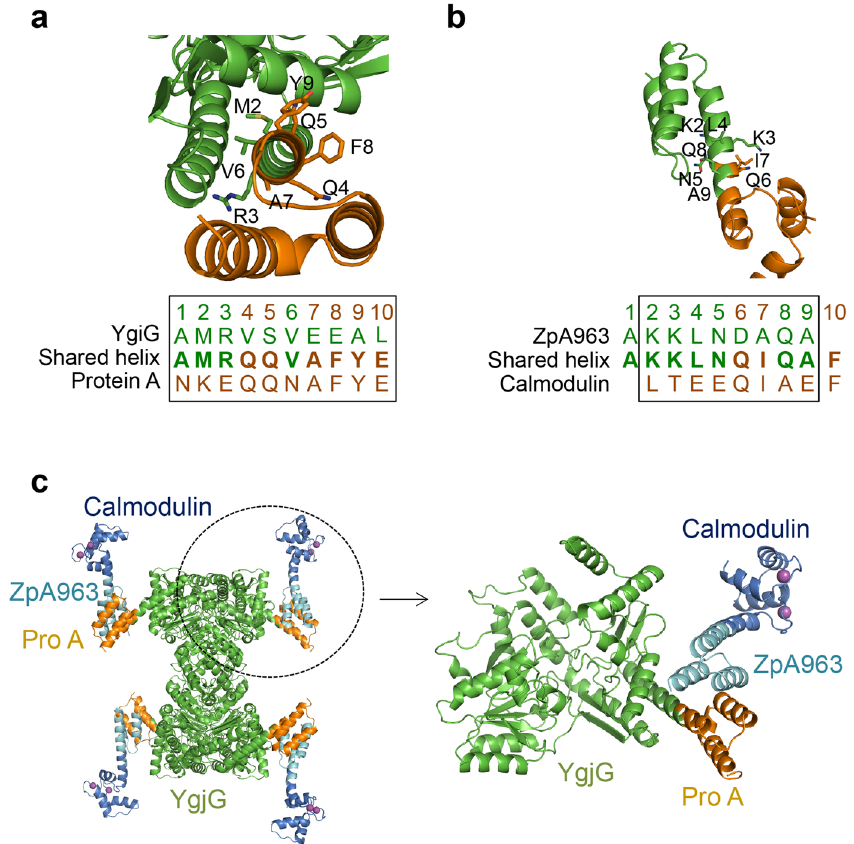
Figure 3. Construction of a tetrameric protein complex by the shared helix method. Fusion strategies of the YgiG-protein A ( a ) and the ZpA963-calmodulin ( b ) by the shared helix method. Models of the shared helix regions of the fusion proteins are shown above. The amino acid sequences of the shared fusion helix are written below. Sequences of the shared region are marked with a box. ( c ) The crystal structure of the YgjG-protein A and the Zpa963-calmodulin complex. A magnified view of one of the four subunits is shown on the right. The calcium ions bound to the calmodulin domain are drawn as purple